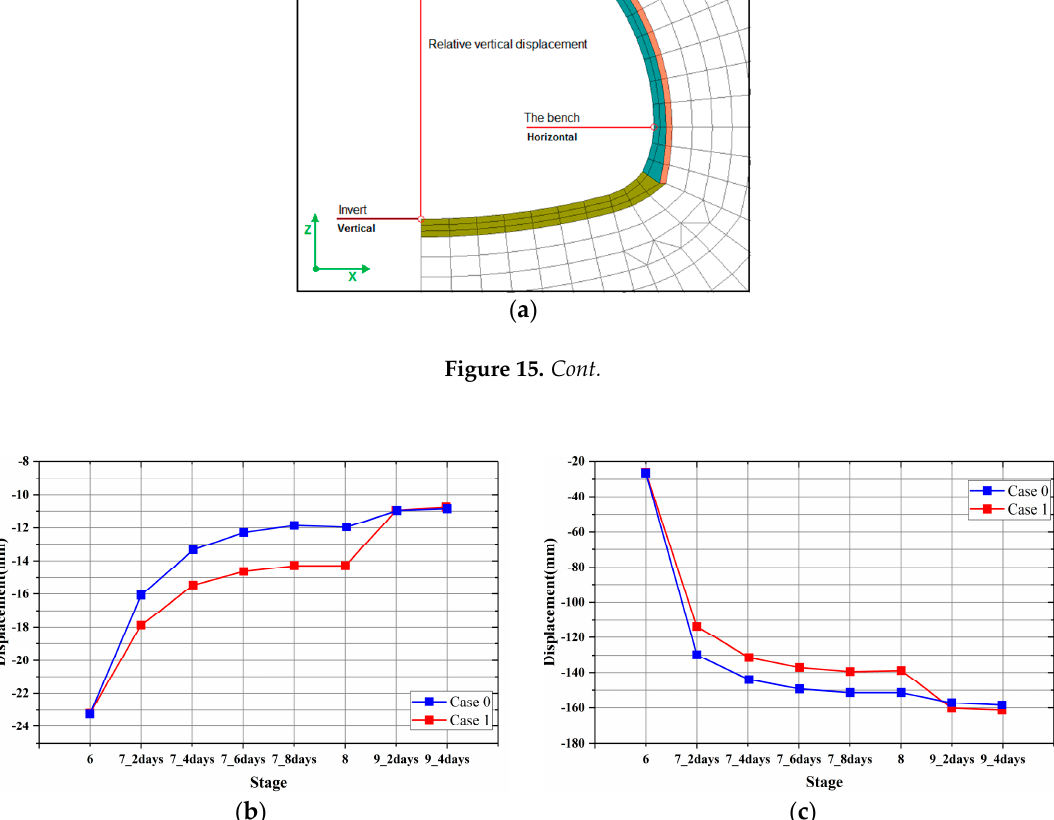
Figure 16. The schematic diagram of the multiple times grouting in the on-site test. ( a ) Grouting bolts layout; ( b ) grouting rendering. ( a ) ( b ) Figure 17. The effect of the new grouting method. ( a ) The grouting process; ( b ) the effect after grouting. Grouting bolt